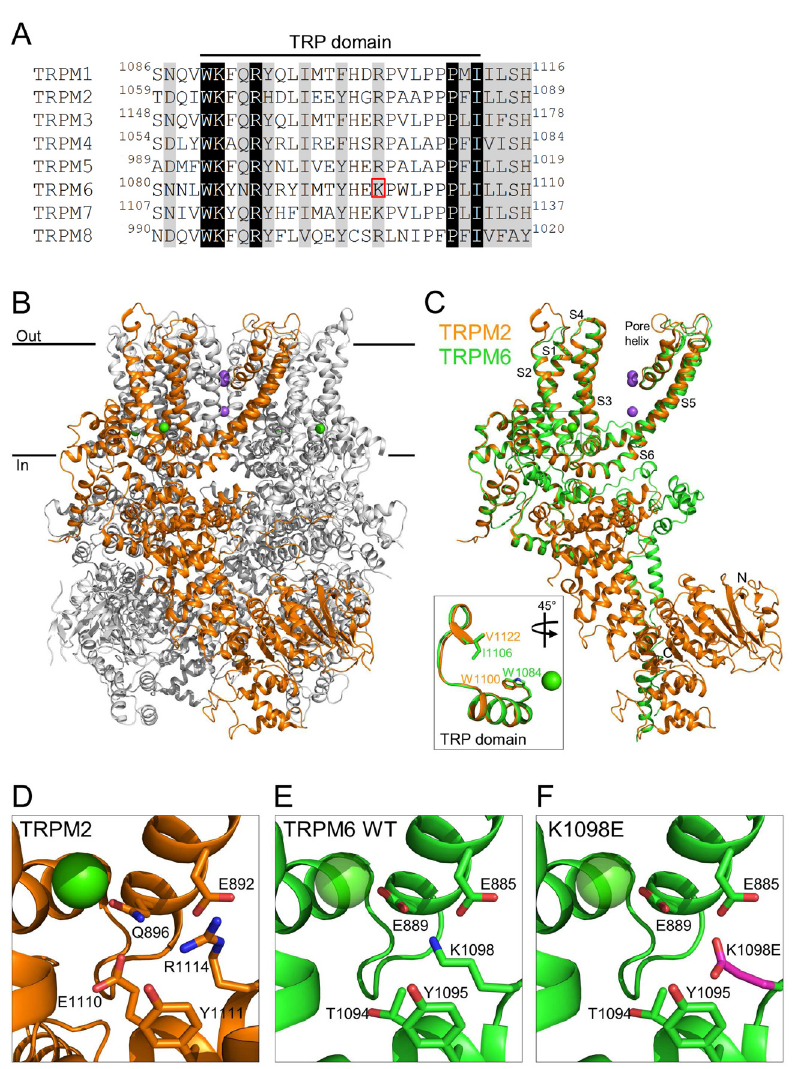
Figure 2. The TRPM6 K1098E variant affects a conserved basic residue in the TRP domain. ( A ) Sequence alignments of TRP domain residues from human TRPM1-TRPM8. Fully-conserved residues are highlighted in black and semi-conserved residues in grey. TRPM6 K1098 is outlined in red. ( B ) Cryo-EM structure of Ca 2+ - and Na + -bound TRPM2 (PDB 6CO7). One monomer of the homotetrameric channel is highlighted in orange and the co-ordinated Ca 2+ and Na + ions are shown as green and purple spheres, respectively. ( C ) Superposition of the TRPM2 monomer (orange) and TRPM6 homology model (green). The TRP domain region (box and inset), wherein the TRPM6 K1098E variant lies, is shown to highlight the predicted structural homology between TRPM6 and TRPM2. The Ca 2+ ion (green sphere) is shown for orientation. ( D ) Close up view of TRPM2 Q896 and E1110 involved in co-ordination of the Ca 2+ ion (green sphere) and R1114 (homologous to TRPM6 K1098, shown in ( E )) predicted to form a stabilising interaction within the TRP domain. ( F ) Mutation of TRPM6 K1098 to glutamate (magenta) is predicted to disrupt stabilising TRP domain interactions. The relative position of the Ca 2+ ion (green sphere) in TRPM2 is shown in ( E ) and ( F ) for